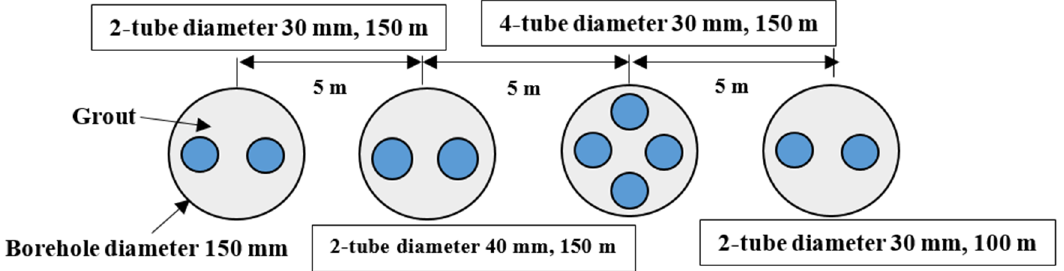
Figure 11. Cross section of ground heat exchangers.